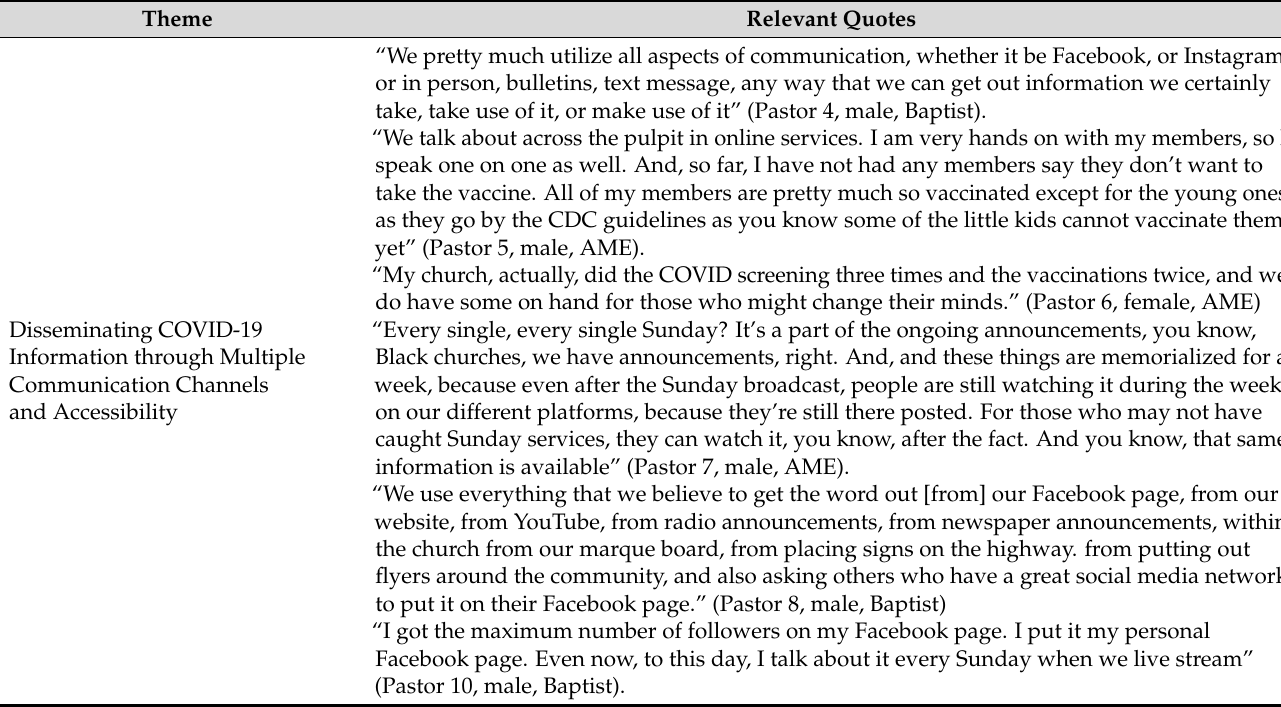
Table 1. Themes and relevant